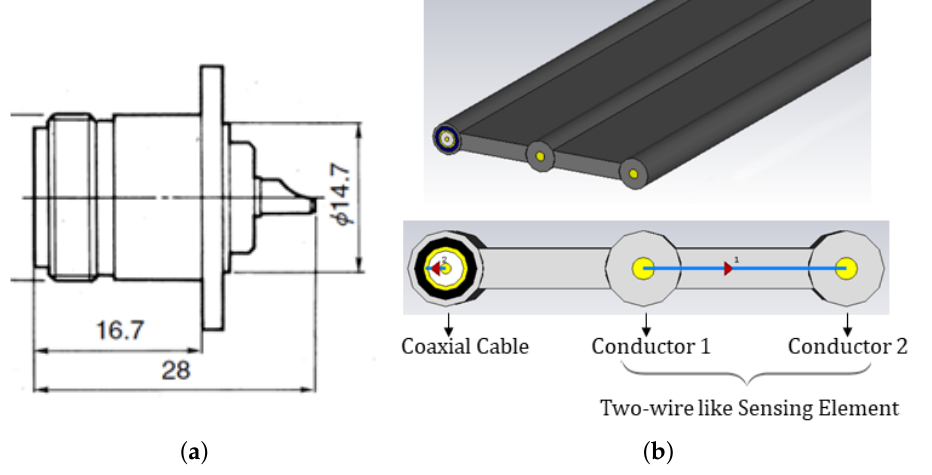
Figure 2. Sketch of the adopted sensing elements: ( a ) Punctual Coaxial Probe (PCP) with dimension in mm; ( b ) Diffused Sensing-Element